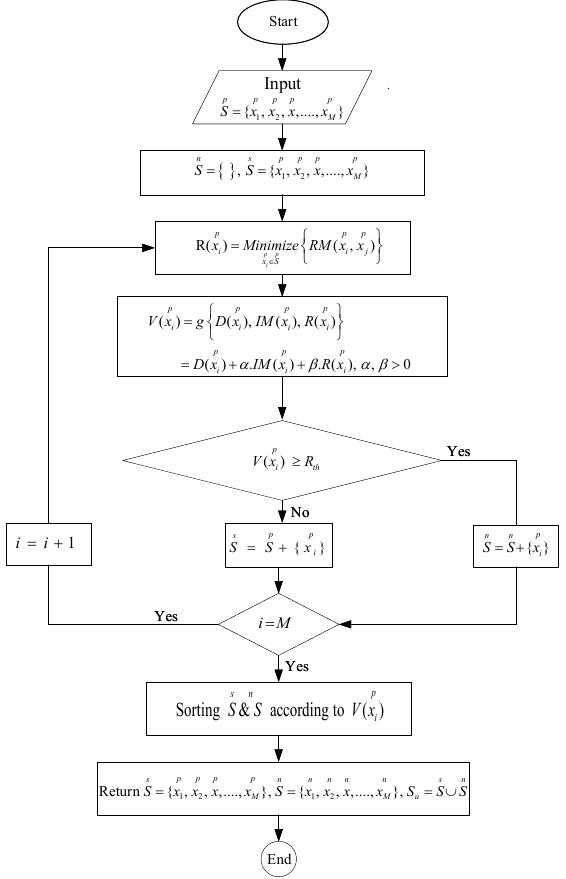
Figure 3. Flow chart of the filtering phase.